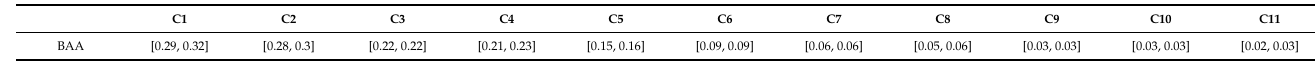
Table 9. Border approximate area.